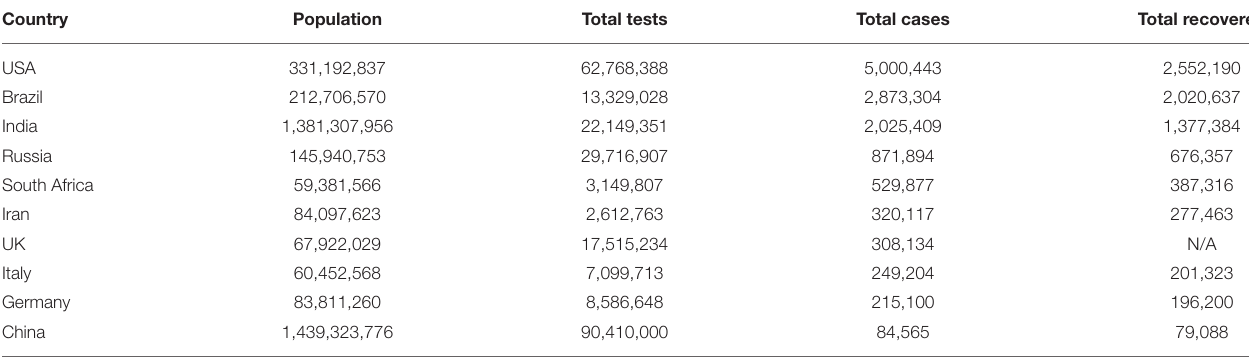
TABLE 1 | Source of Data: http://www.smaartrapidtracker.org, accessed on August 6, 2020. Country